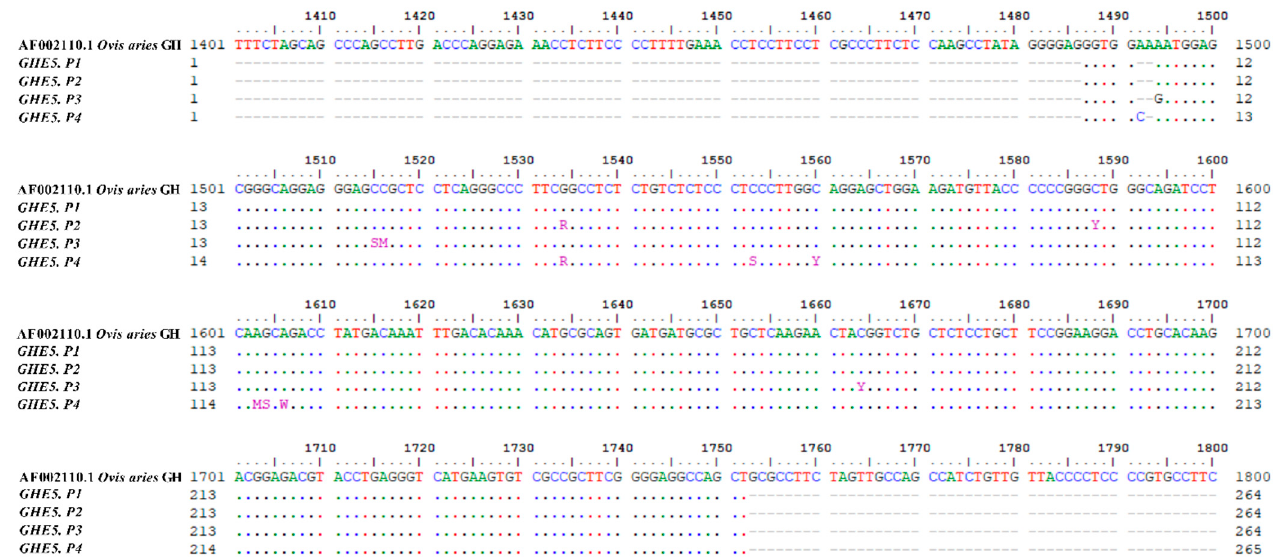
Figure 1. ClustalW algorithm-based alignment of the GHE5 variants’ sequences with the NCBI reference sequence AF002110.1.